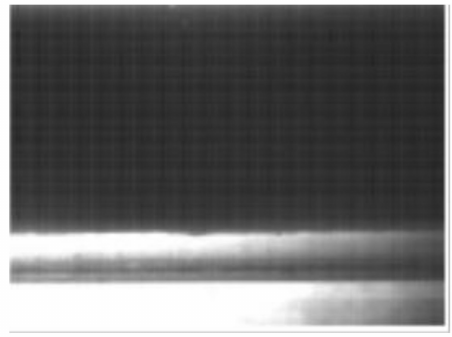
Figure 14. Flow pattern at U oil = 0.122 m / s, U water = 0.081 m / s—experiment [11].